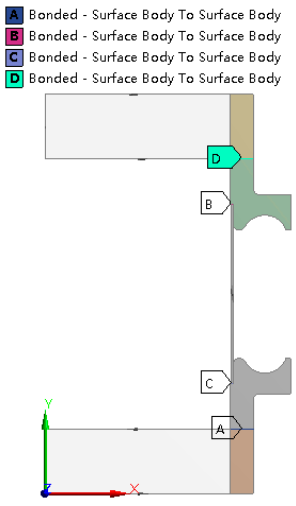
Figure 4. Illustration of bonded contact positions.